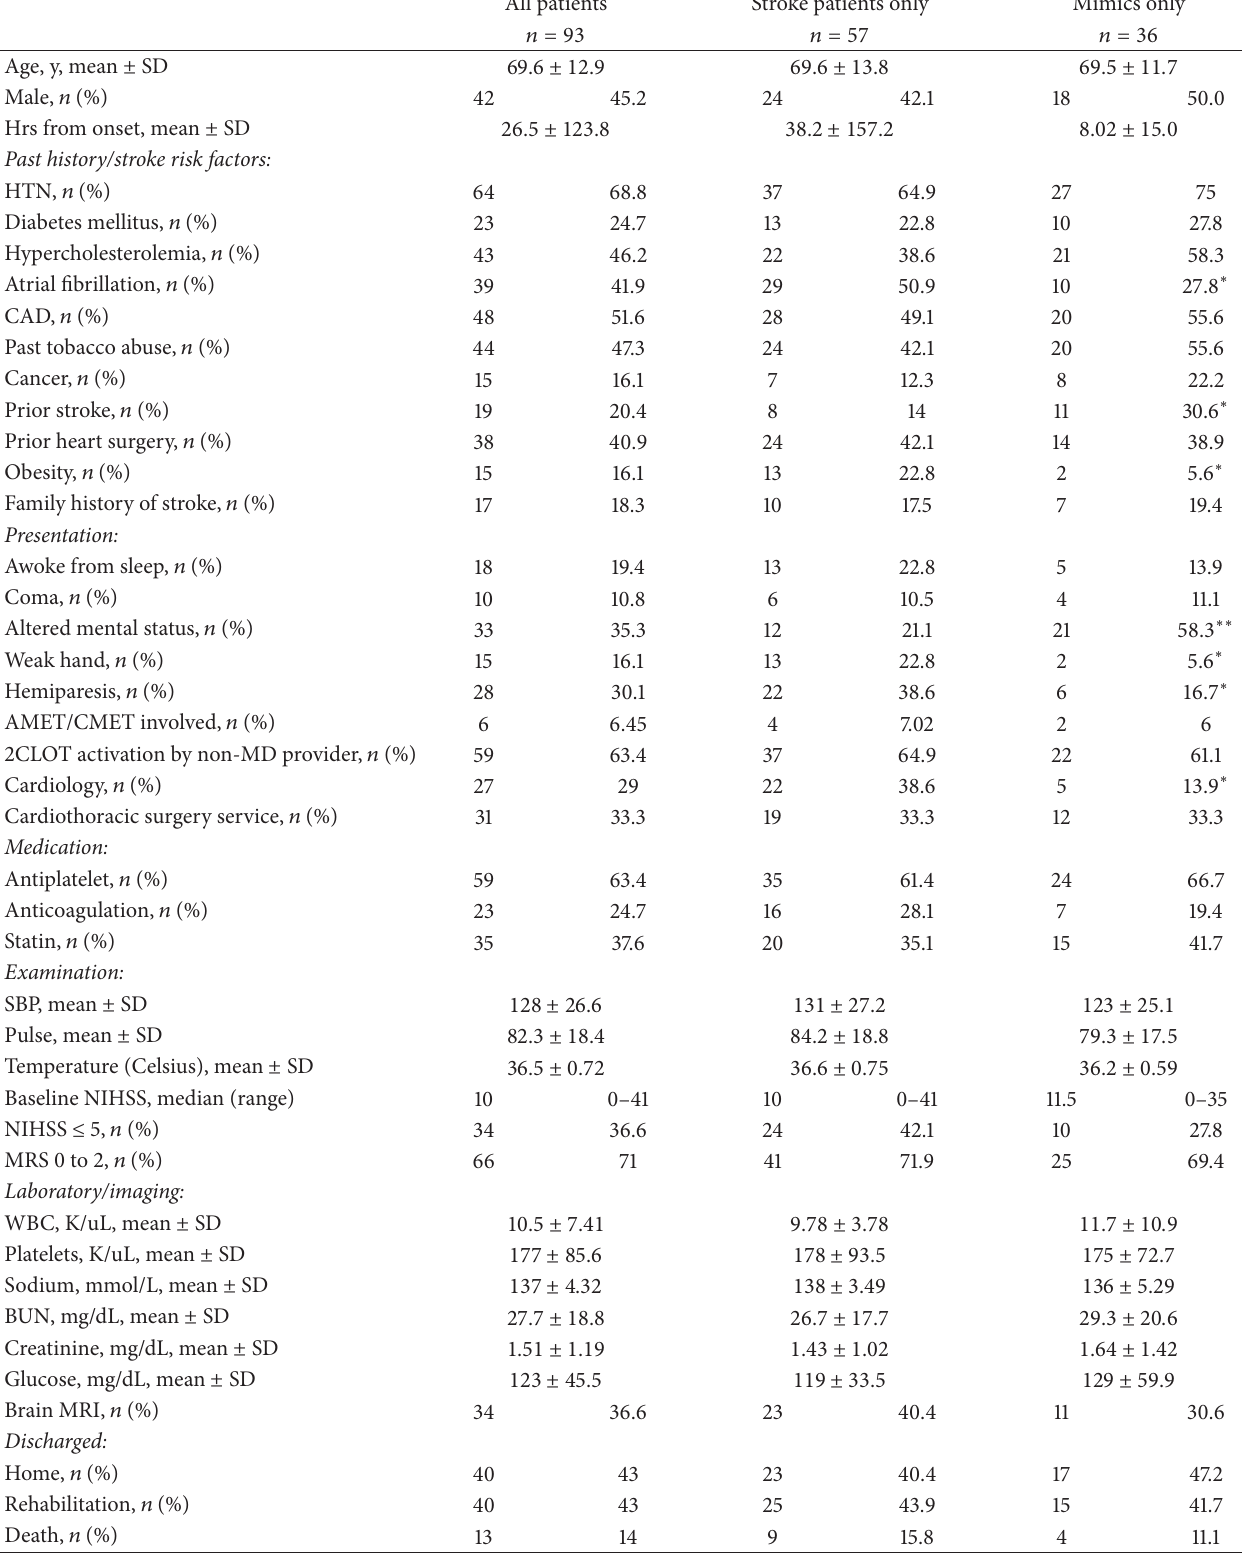
Table 1: Patient characteristics of strokes and stroke-mimics. All